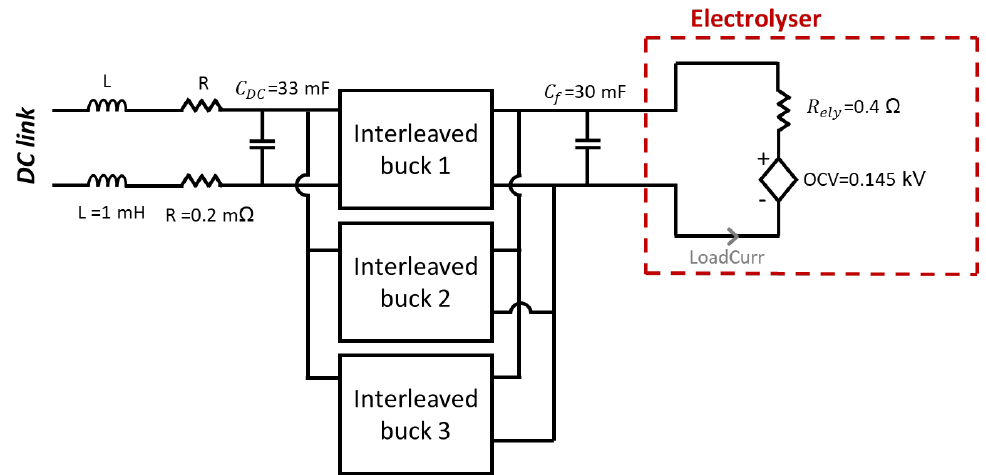
Figure 6. RSCAD ® model of the buck converter and electrolyser cell in Scenario 1, as referred to in Figure 5.